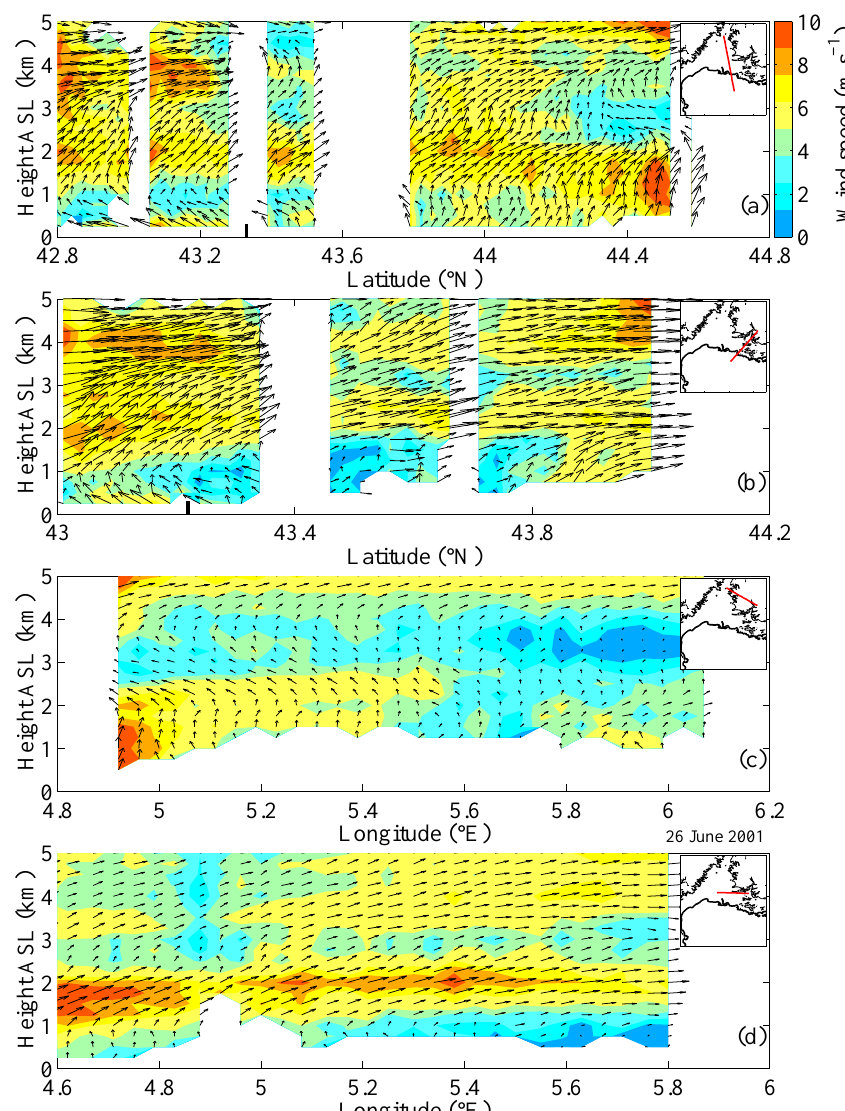
Fig. 6. Same as Fig. 4 but on 26 June 2001 at about 14:00 UTC (the time of the entire DLR Falcon 20 flight is given in Table 1). On panels (a) and (b) , the coastline is at about 43.33 ◦ N and 43.22 ◦ N, respectively.